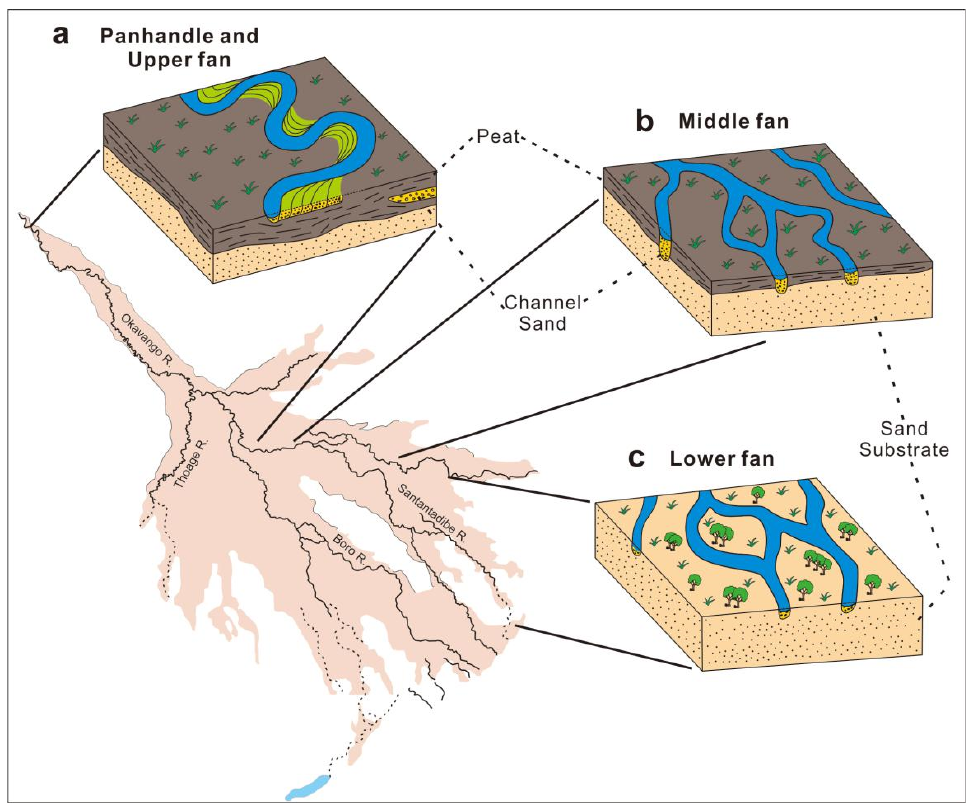
Figure 4. Schematic diagram showing the varying style of river channel and overbank sediments in ( a ) the panhandle and upper fan, ( b ) middle fan, and ( c ) lower fan sub-environments of the Okavango Fan (modified from Stanistreet and McCarthy, 1993).